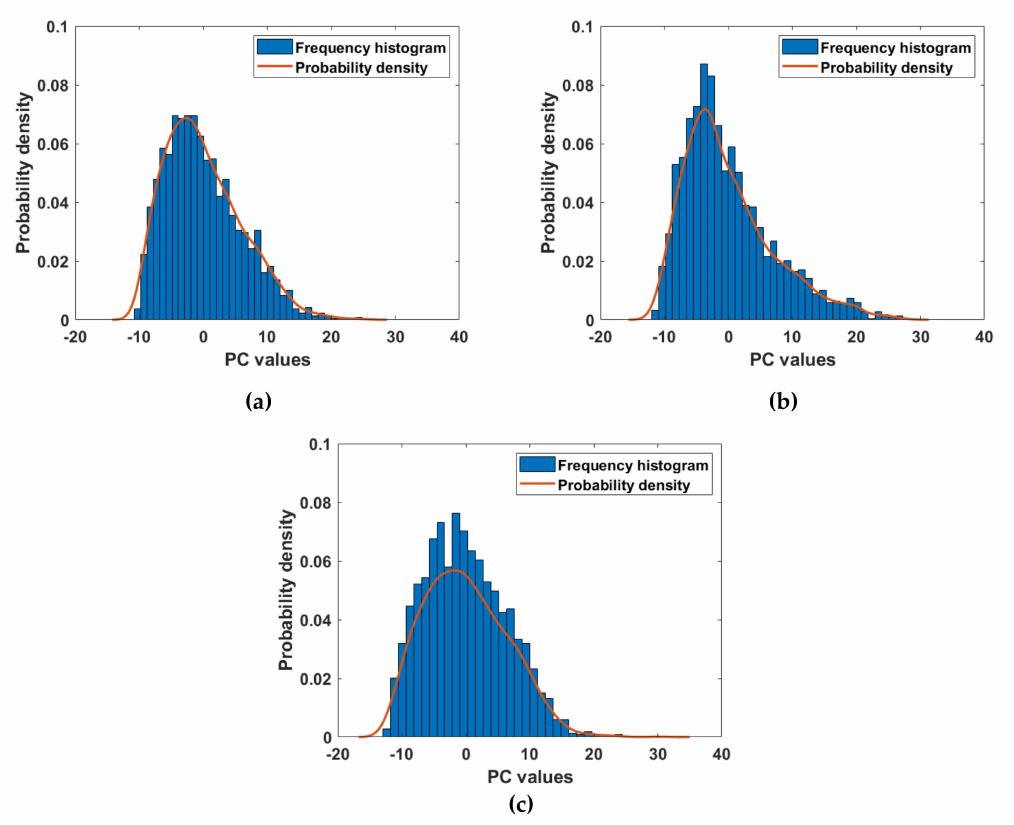
Figure 4. Histogram of frequency and probability plot of the first PC ( a ) at the 7th hour, ( b ) at the 15th hour, ( c ) at the 23rd